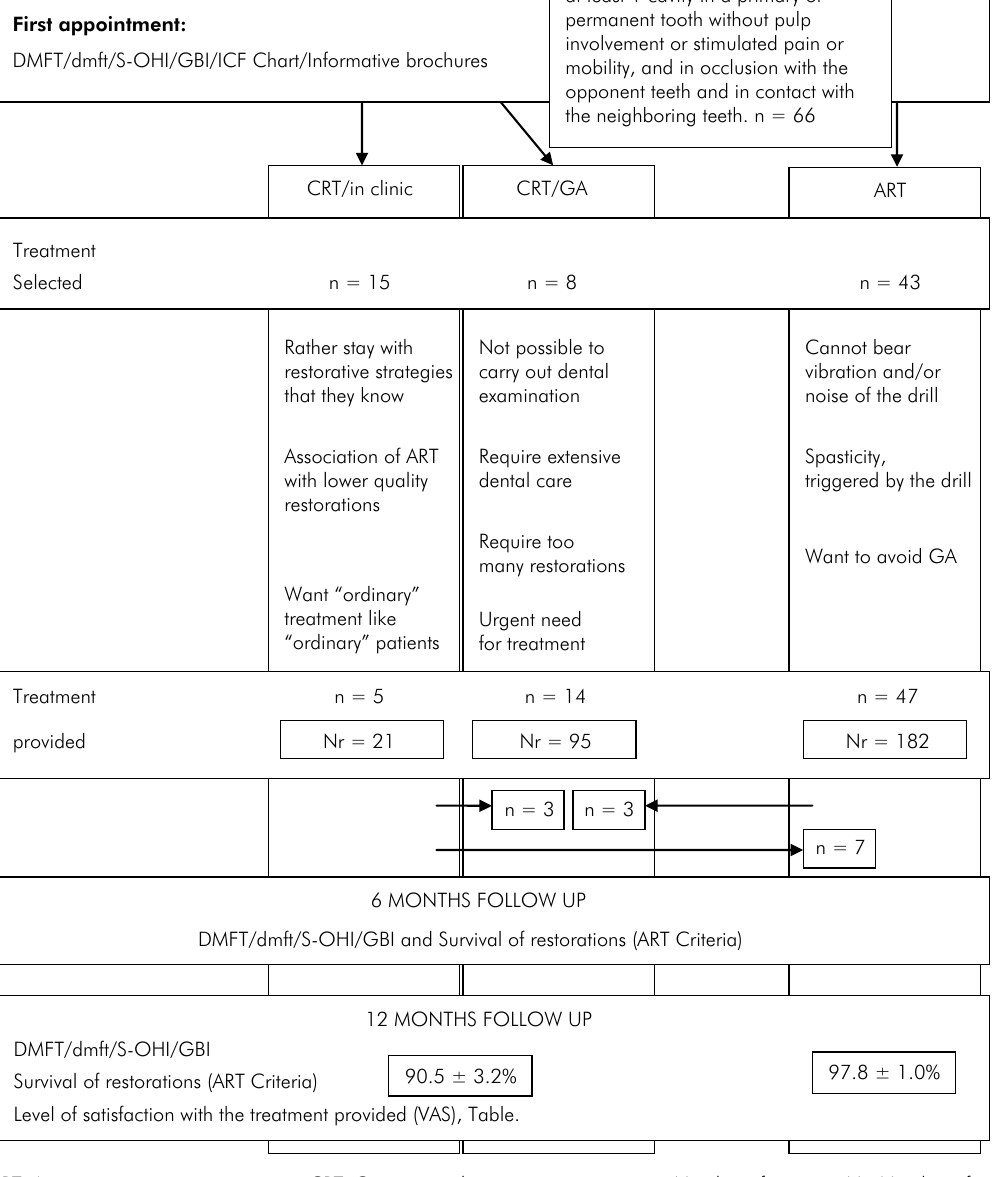
Figure. Flow chart of the selection and provision of different treatment options by treatment group and evaluation period of the study